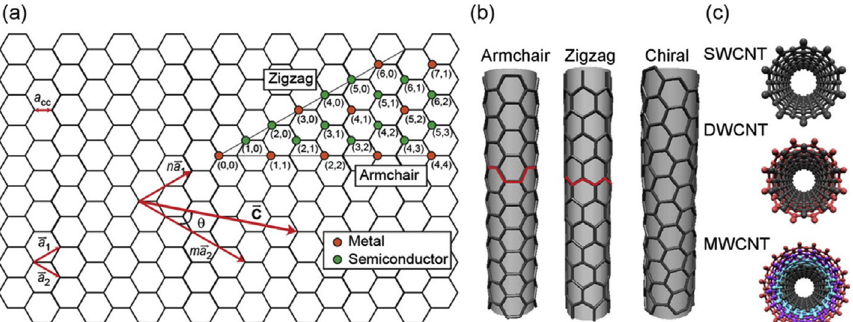
Figure 1. ( a ) Unrolled SWCNT showing chiral vector (cid:126) C and how different values of the integers n and m affect the electrical property of the SWCNT. ( b ) The direction of the chiral vector affects the appearance of the nanotube. Examples of CNTs are shown: (4, 4) armchair shape, (6, 0) zigzag shape, and (5, 3) chiral shape; and ( c ) “Ball and stick” representation of single-walled CNT (SWCNT), double-walled CNT (DWCNT), and multi-walled CNT (MWCNT) (images made using Nanotube Modeller (www.jcrystal.com)). Reprinted with permission from Reference [98]. Copyright © 2016 American Chemical